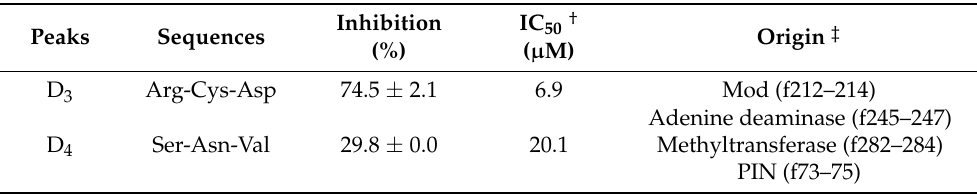
Table 5. Peptide sequences, HMG-CoA reductase inhibitory activities and IC 50 of various peaks (D 1–4 ) from HHP-FH-PR6G